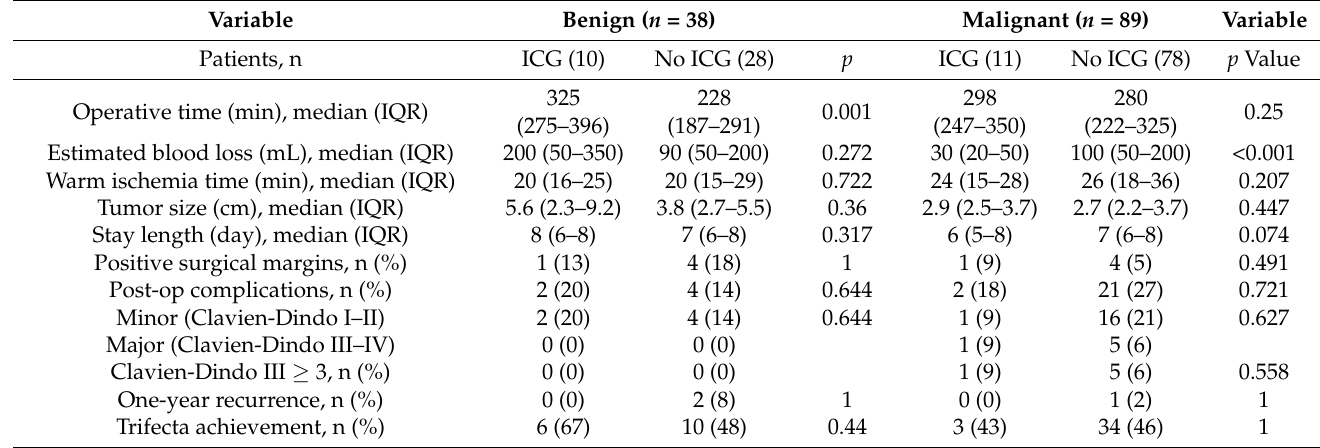
Table 3. Intraoperative and postoperative data of benign and malignant tumors